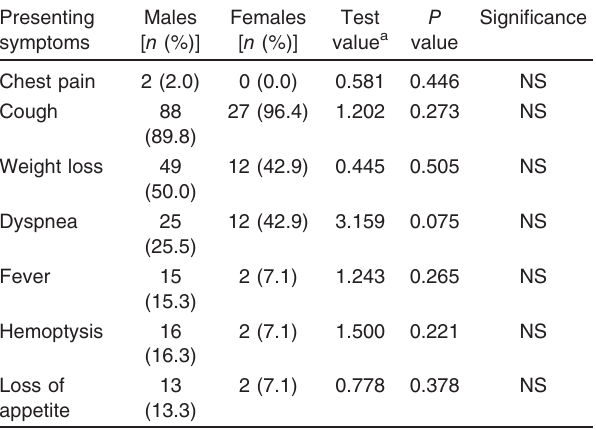
Table 3 Presenting symptoms in males and females with pulmonary tuberculosis Presenting symptoms